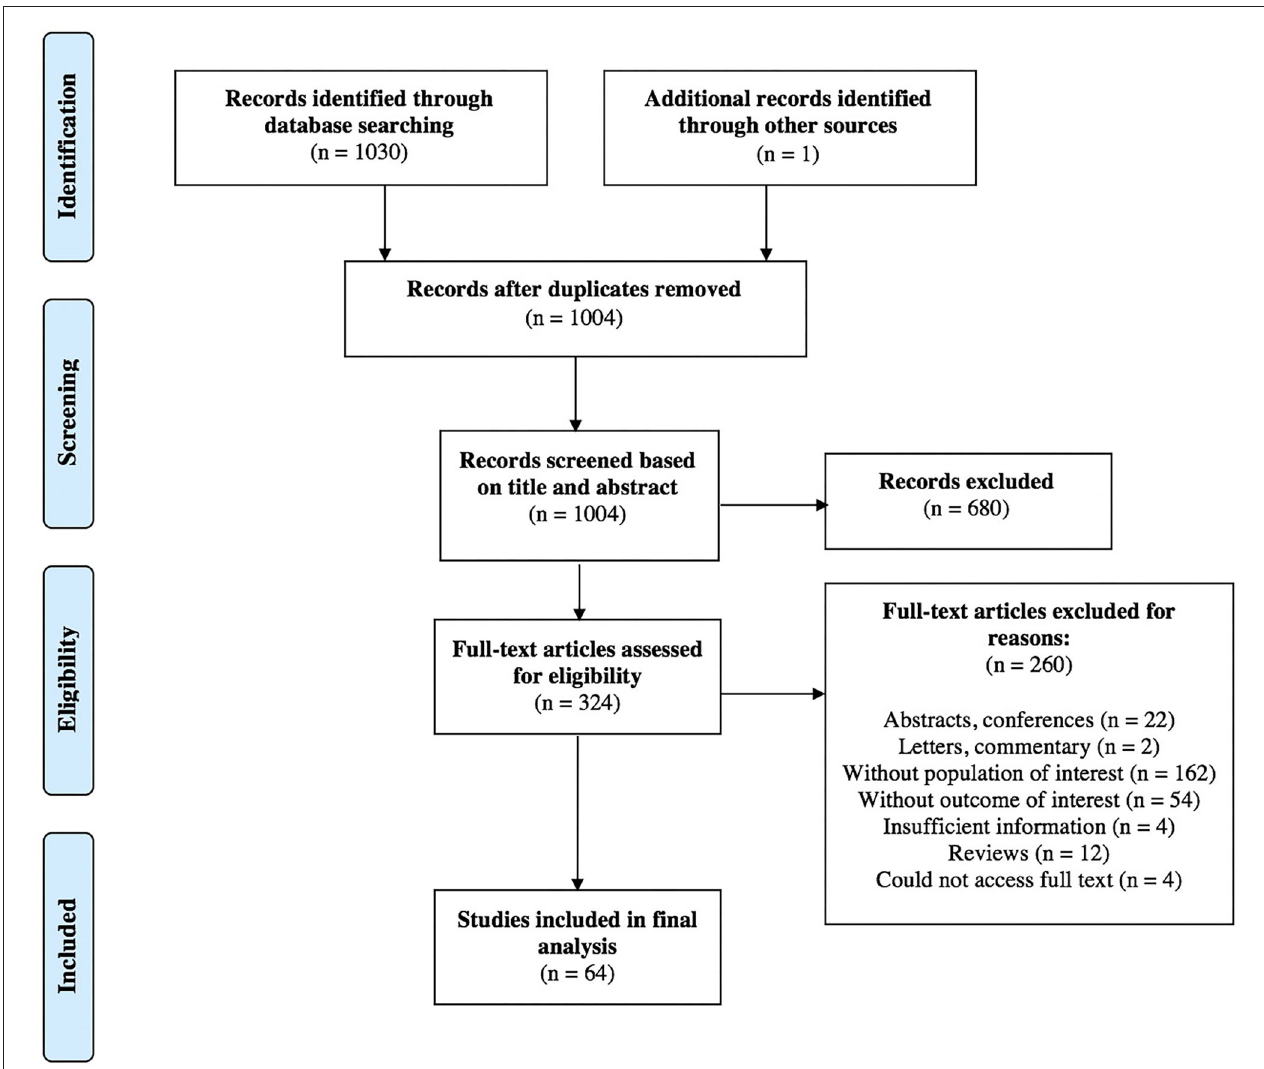
FIGURE 1 | PRISMA flow diagram of selection of studies for inclusion in the systematic